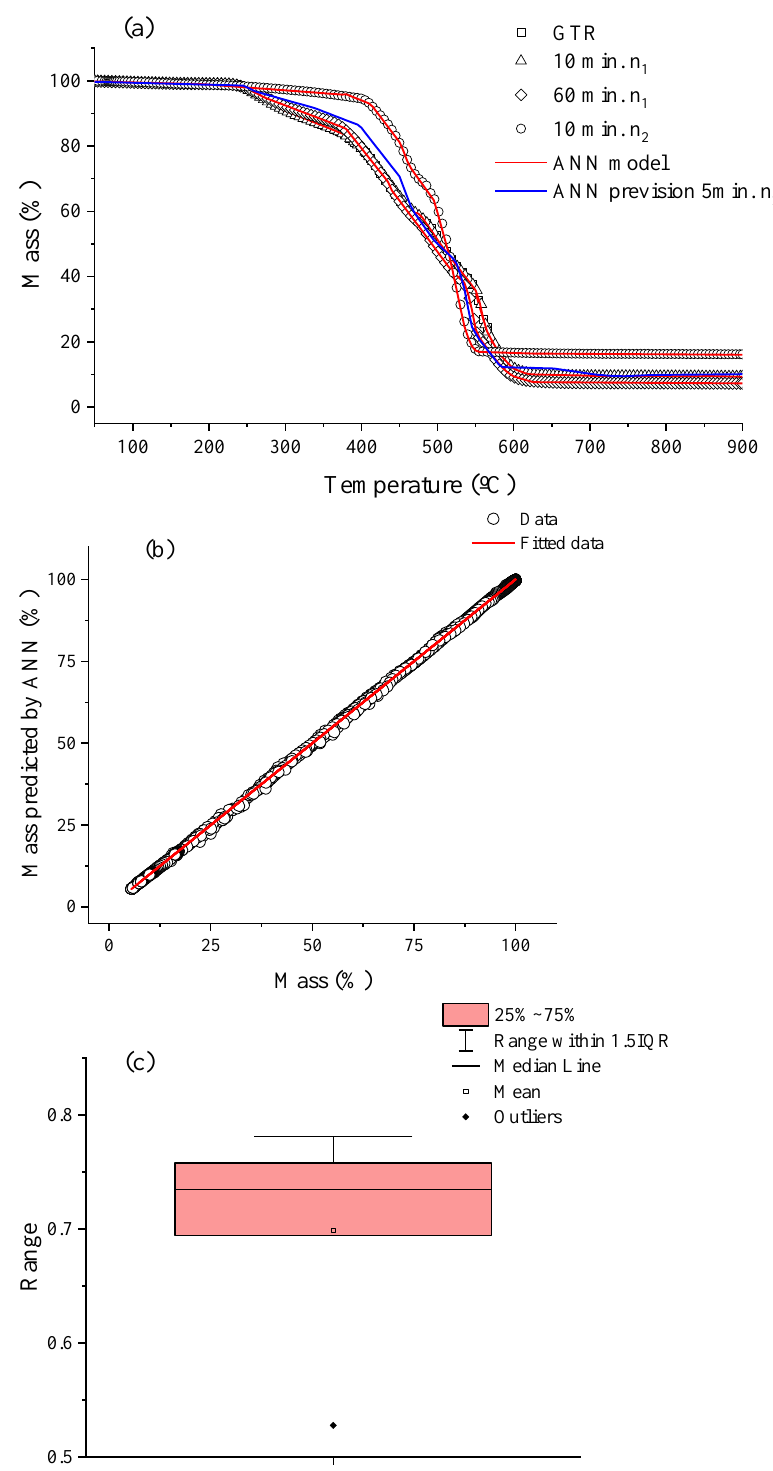
Figure 2. ( a ) TGA curves (20 °C·min −1 ) for GTR samples in different treatment times and speeds. The open dots symbols refer to experimental data, the solid red line to the ANN predicted data, and the solid blue line to a 5 min predicted condition in n 2 . ( b ) Comparison of the data fitted by ANN and experimental data and ( c ) Cross-validation box plot, R 2 > 0.9999.